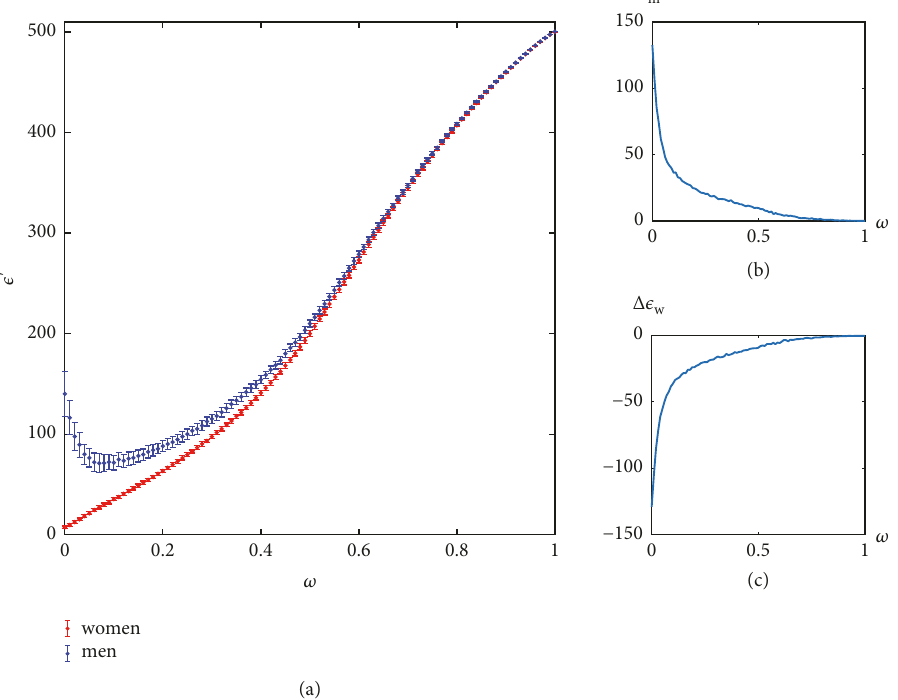
Figure 5: The matching between 1000 men and 999 women, as a function of 𝜔 . The result is averaged over 100 realizations. (a) The average ‘energy’ of men and women; (b) Δ𝜖 𝑚 versus 𝜔 ; (c) Δ𝜖 𝑤 versus 𝜔